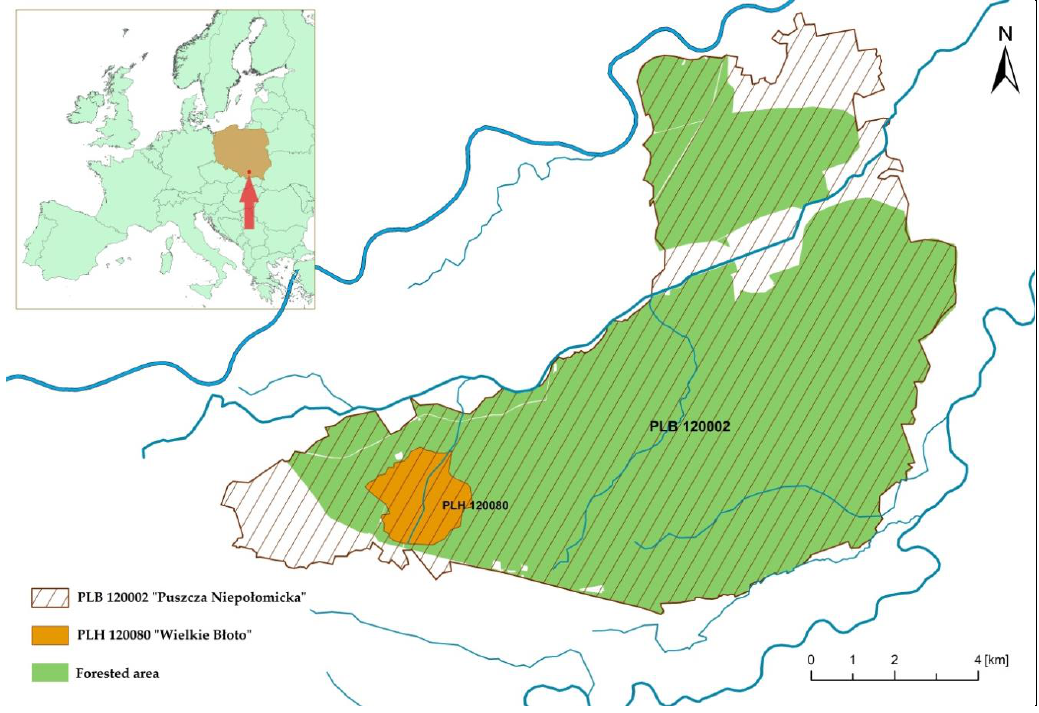
Figure 1. Location of forest complexes and special protection areas within the Natura 2000 network.